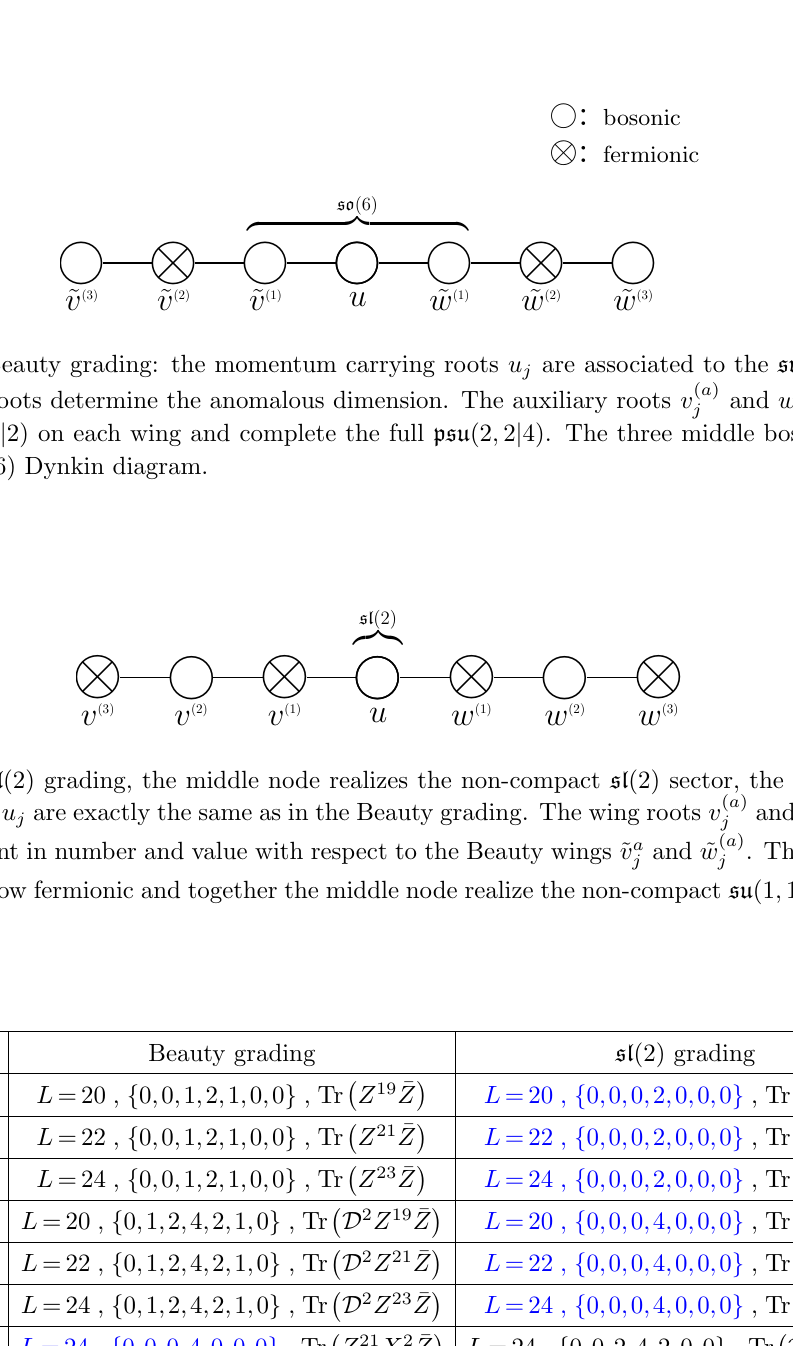
(cid:1) (cid:1) 0 ; s; n; m and their spin chain description. We specify f g , in both beauty and sl (2) D